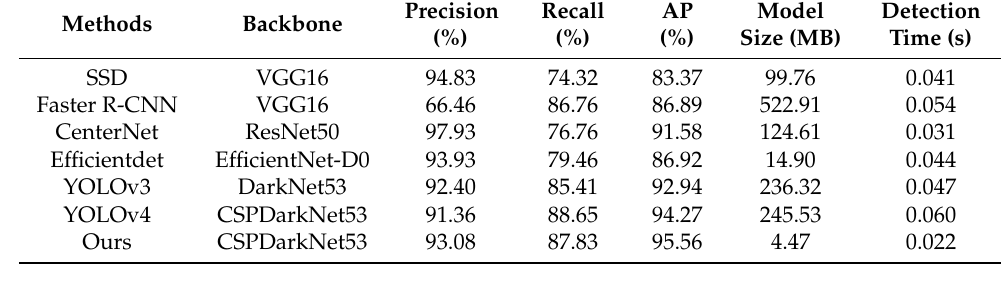
Table 2. The performance of our method under different scenes.